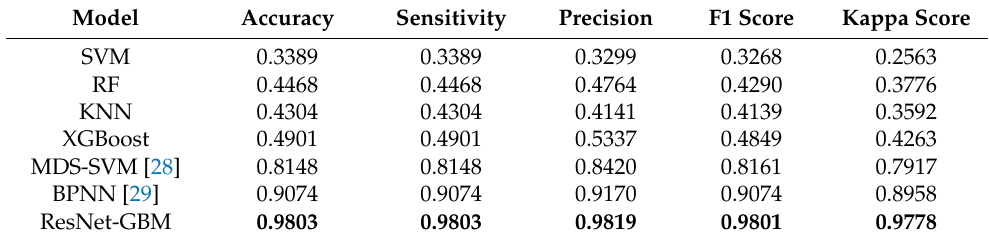
Table 8. Classification results of seven models in Experiment IV.